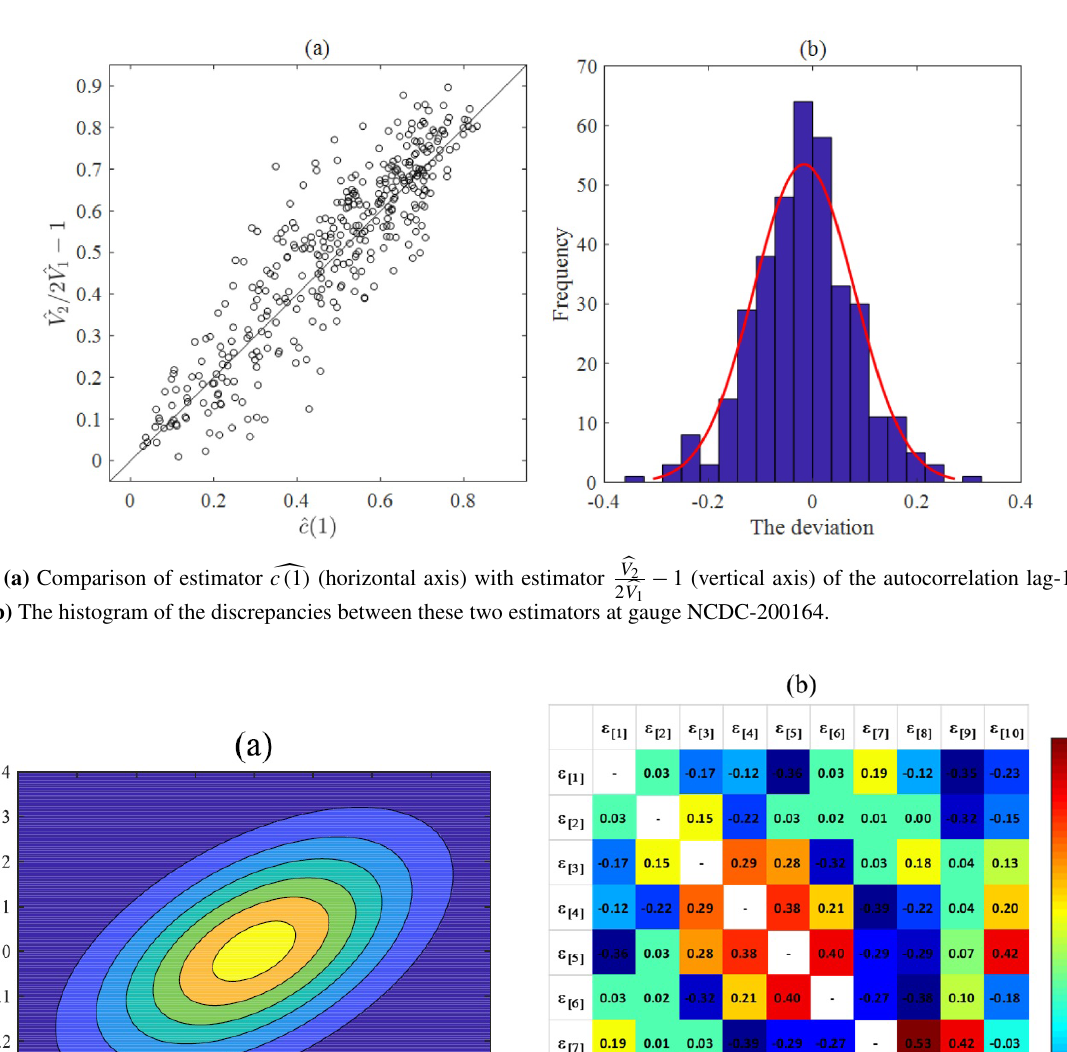
Figure 8. (a) Relationship between ε [ 7 ] and ε [ 8 ] and the fitted bivariate distribution. (b) Color map of the correlation coefficient between different ε [ i ] s at gauge NCDC-200164 on